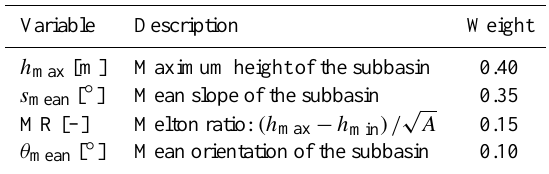
Table 1. Description of the geomorphological variables used for DF susceptibility assessment and weight estimated with Eq.